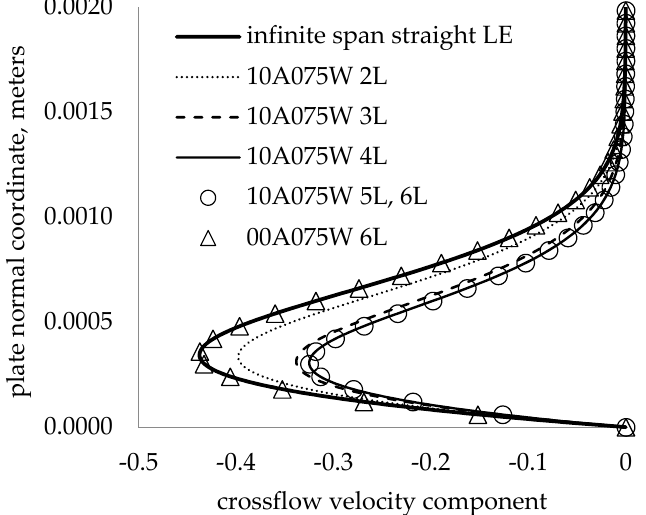
Figure 4. Velocity profiles in the crossflow direction at 80% chord.